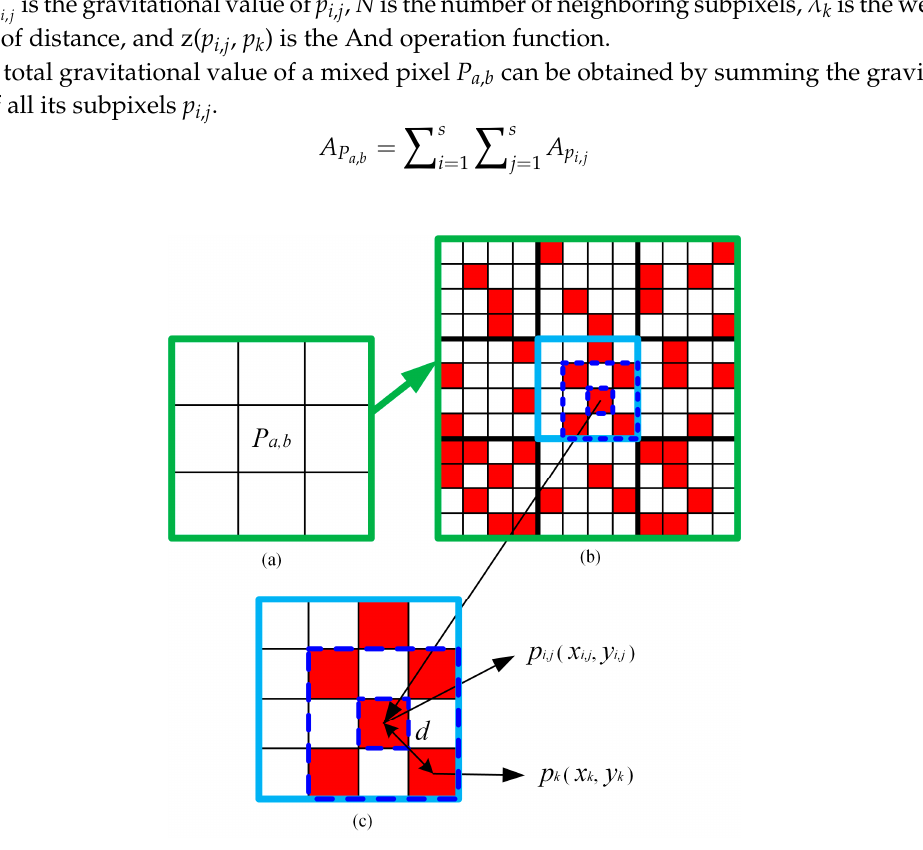
Figure 1. Spatial correlations of the subpixels in the pixel-swapping algorithm (PSA) ( S = 4). ( a ) Mixed pixels, ( b ) high-resolution image, ( c ) subpixels in P a , b.